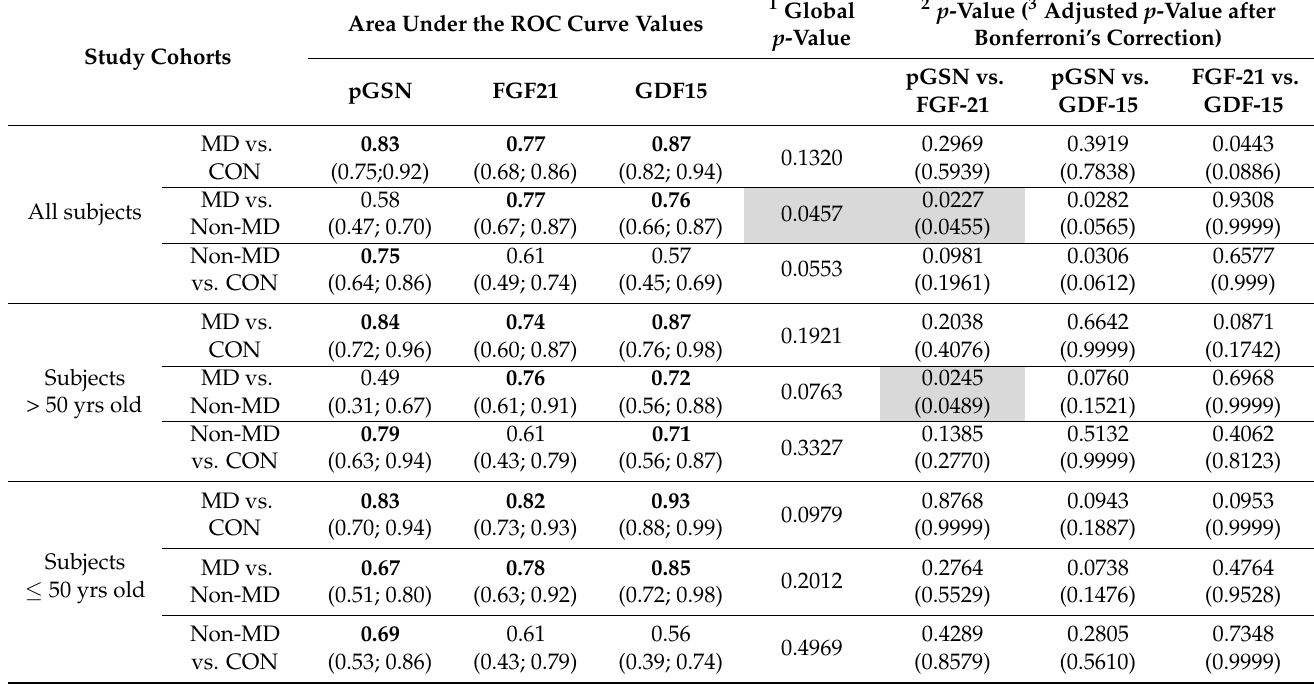
Table 2. Discrimination ability of plasma biomarkers pGSN, FGF-21, and